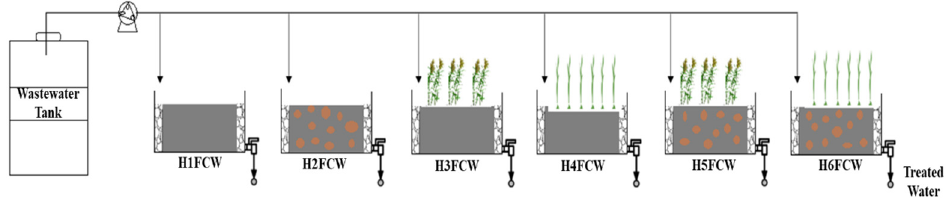
Figure 1. Experimental scheme of the mesocosm horizontal flow constructed wetlands